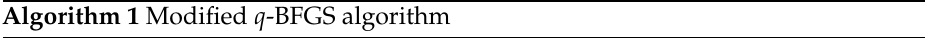
Algorithm 1 Modified q -BFGS